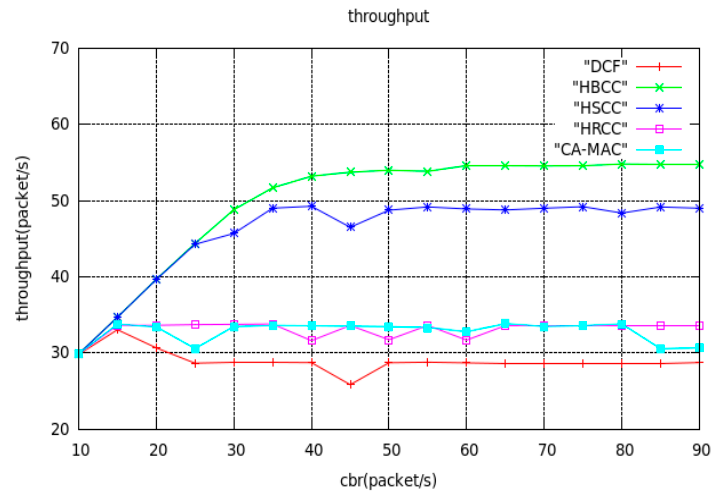
Figure 7. Curves of average saturation throughput with network load.